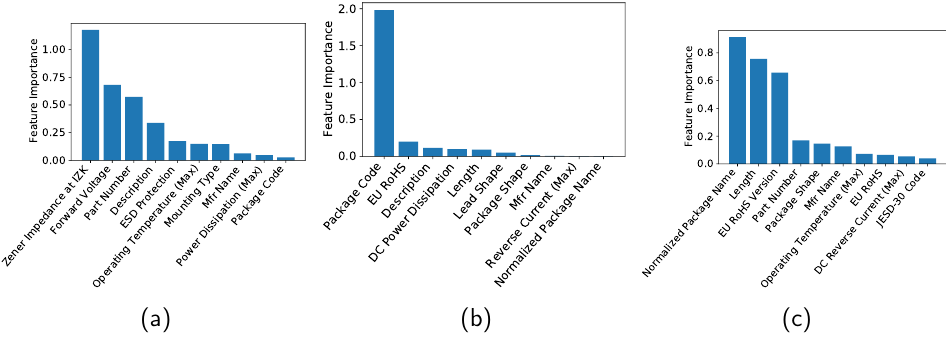
Figure 5. Feature importance of ( a ) Zener diodes, ( b ) varactors, and ( c ) bridge rectifier diodes when a decision tree is applied.